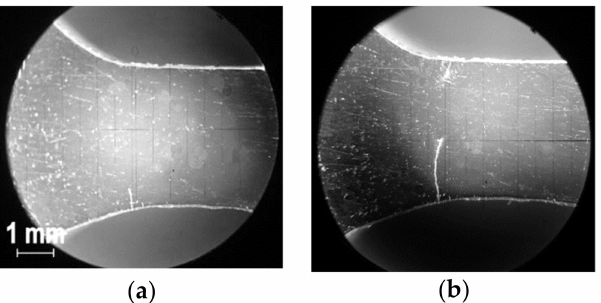
Figure 11. Selected stages of crack development in a specimen with concave welds in bending without HT (heat treatment), where: ( a ) crack initiation; ( b ) crack initiation and propagation.